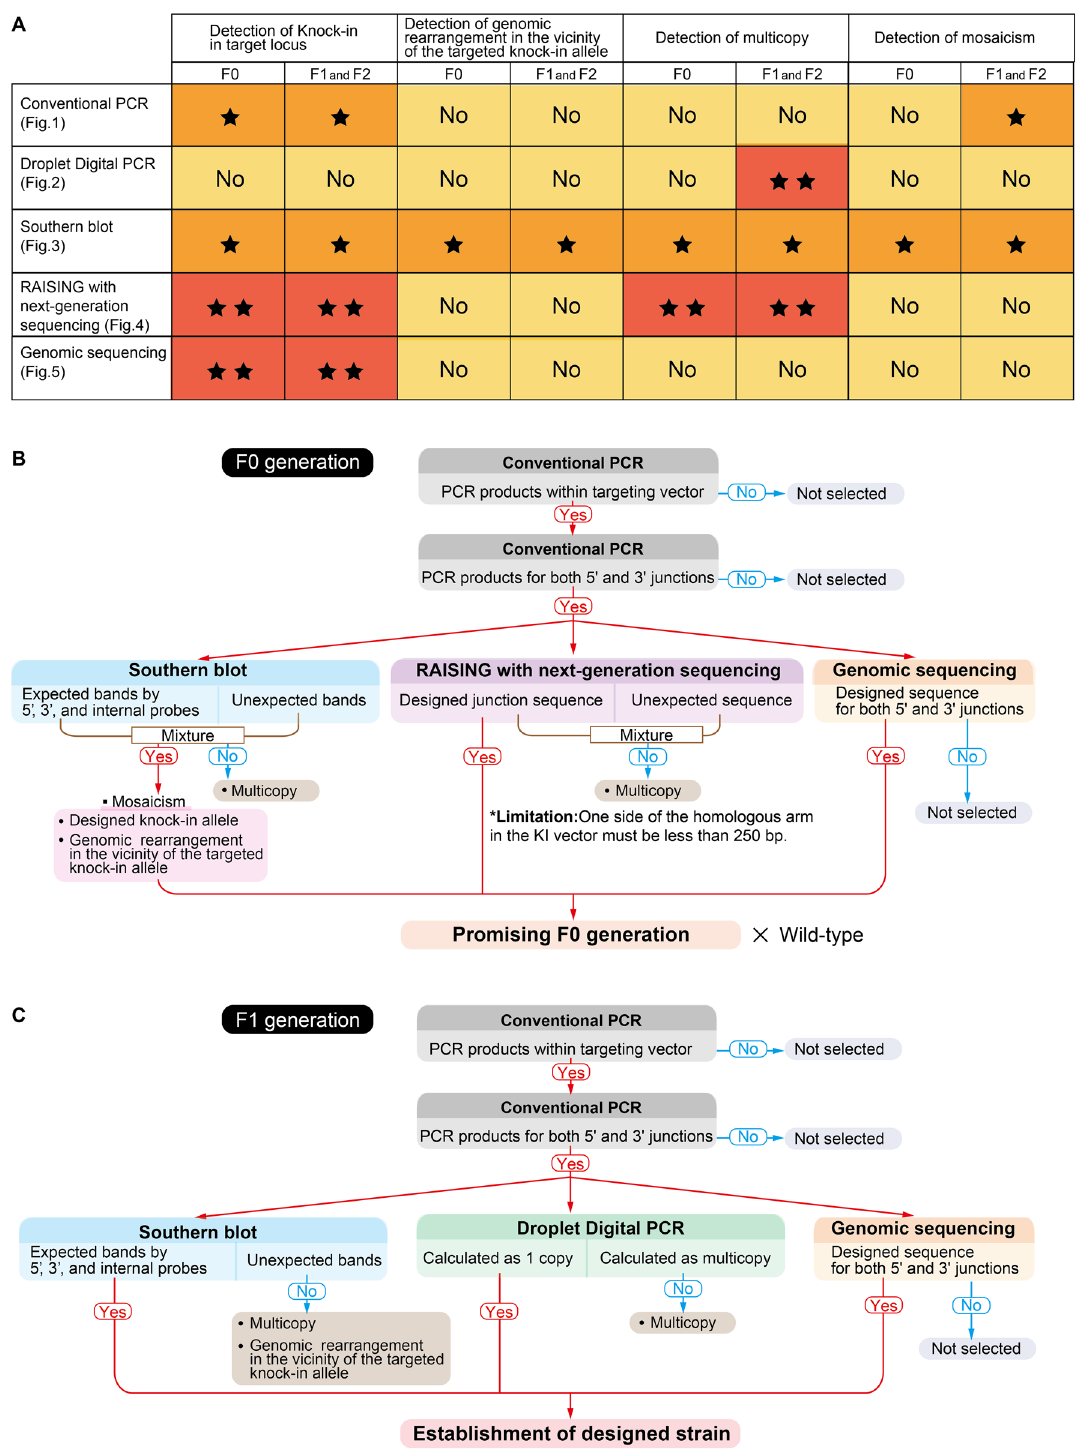
Figure 7. Comparison of detection performance amongst the five analytical methods for four possible knock-in events using CRISPR-cas9, the selection process for a promising F0 generation, and the designed strain in this study. ( A ) Based on results obtained from this study, the superiority of each method for detecting the mutation events is summarized. **More informative, *informative, and No Not informative or least information. ( B ) The flow for sorting a promising F0 generation is illustrated. Southern blotting was able to detect mosaicism and multicopies. The RAISING method was also capable of detecting multicopies. Conventional PCR and genome sequencing were unable to detect mosaicism and multicopies. ( C ) The flow for establishing a designed strain in the F1 generation is illustrated. Southern blotting identified multicopies and genomic rearrangements near the target knock-in allele. Droplet digital PCR could distinguish multicopies. Conventional PCR and genome sequencing were unable to detect